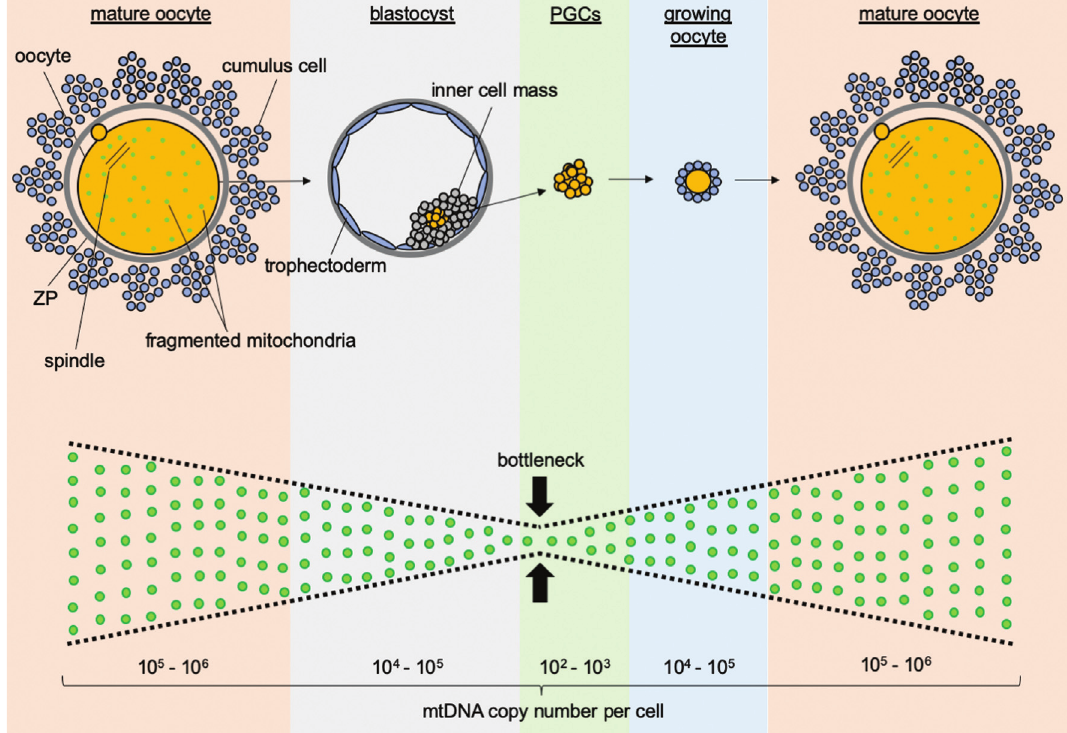
Figure1 -Mitochondrialkineticsinthefemalegermline.Throughoutgermlinedevelopment,thenumberofmitochondrialDNA(mtDNA)moleculesper cellvariesfrom10 5 -10 6 inmatureoocytes(beforefertilization),10 2 -10 3 inprimordialgermcells(PGCs)and10 5 -10 6 backtomatureoocytes.Thisvari- ation in copy number accounts for the mitochondrial genetic bottleneck, which forces segregation of mtDNA molecules. In line with this, the mitochon- drial network is fragmented in oocytes, allowing efficient partitioning of mitochondria among hundreds of cells until embryonic implantation. In addi- tion, only few cells in the embryo differentiate into PGCs, supporting a sampling effect towards selection of a single mtDNA genotype to populate the future